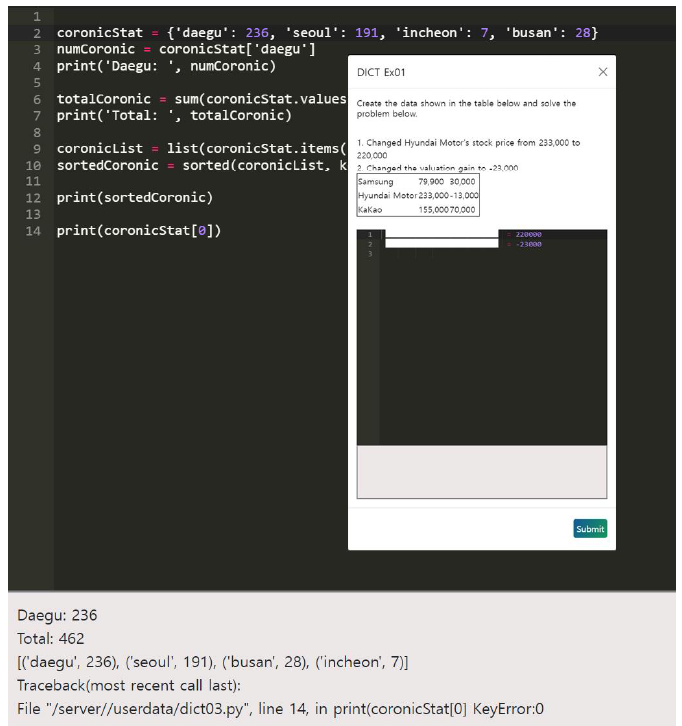
Figure 6. Quiz–additional learning content.